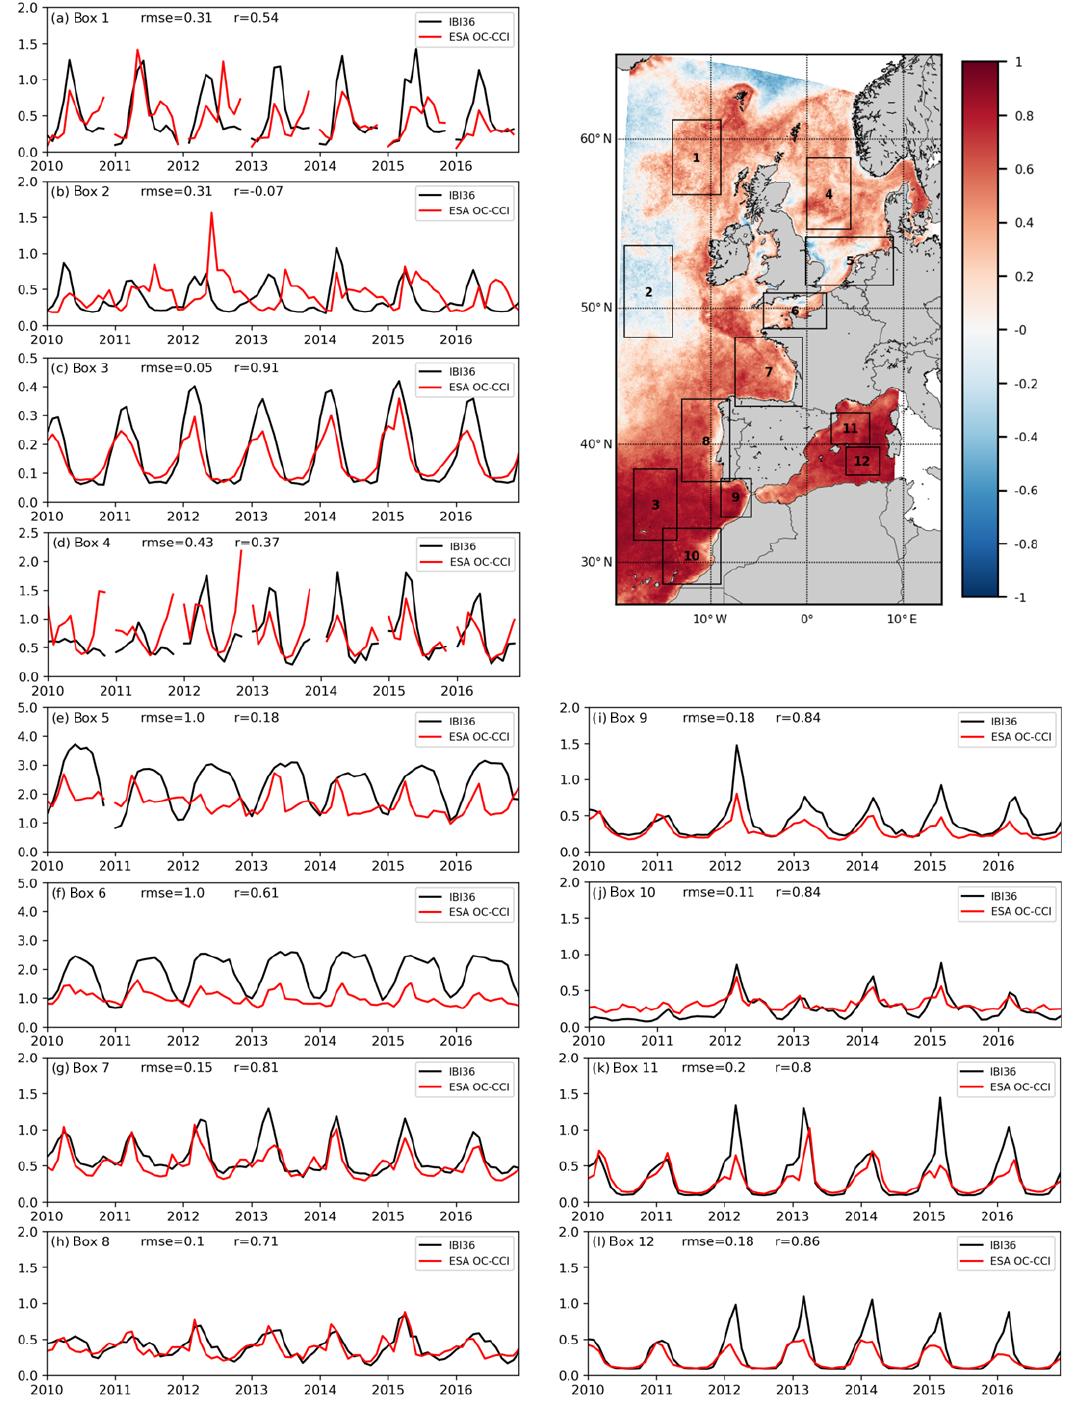
Figure 4. Time series of sea surface Chl a (mgChlm − 3 ) between 2010 and 2016. IBI36 is in black and ESA OC-CCI product in red. Chl a is averaged over the 12 boxes defined in Fig. 1 and reported on the map in the top right. The RMSE ( ( r ) between the model and the data are indicated for each time series. The top right panel represents the spatial distribution of temporal correlation between the model and the observation. Note the different scales on the y